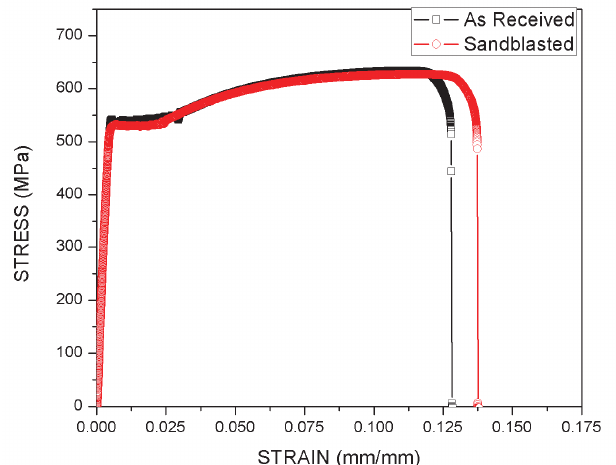
Figure 9: Representative tensile load-displacement curves of as-received as well as sandblasted